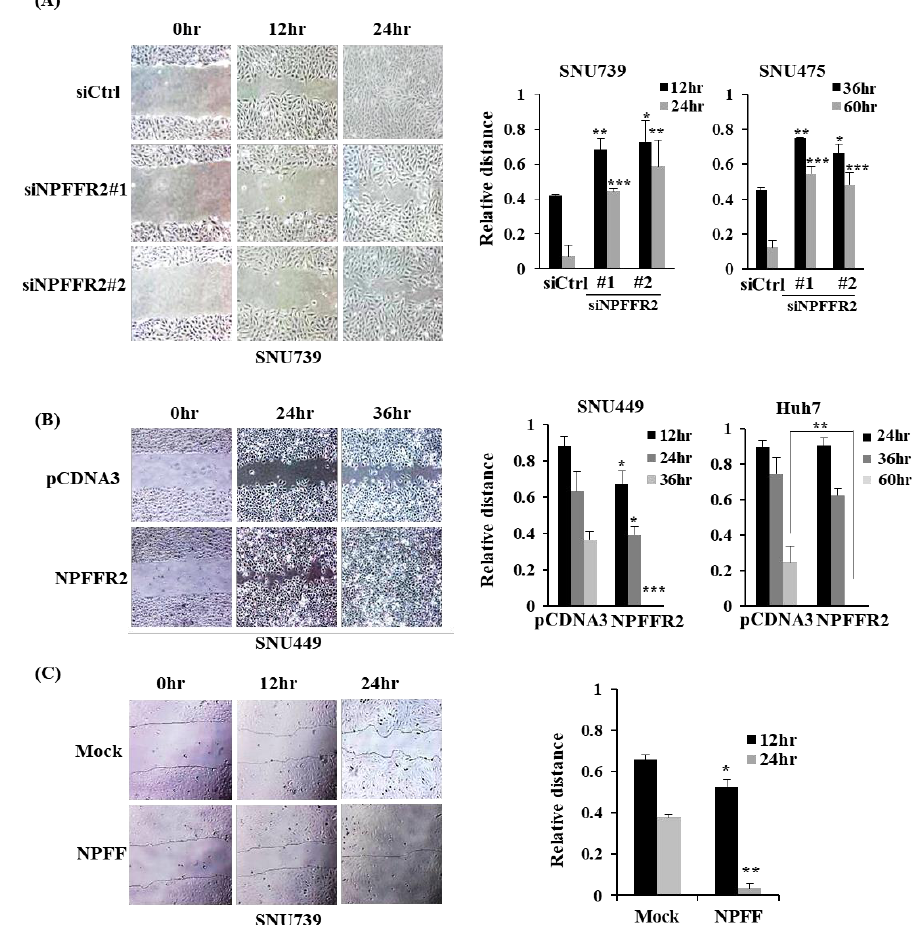
Figure 4. NPFFR2 increases cancer cell migration. ( A – C ) A wound healing assay was performed with indicated HCC cells under conditions where NPFFR2 was depleted by siRNA ( A ), overexpressed by transient transfection ( B ), or activated by ligand ( C ). To verify the migration effect by regulation of NPFFR2 expression, cells transfected with siRNAs ( A ) or plasmids ( B ) for 24 h were prepared for the assay. To verify the migration effect of NFPPR2 ligand ( C ), starved cells were stimulated with complete media containing 3 μM of NPFF. At least three independent experiments were performed, and data are presented as the average of triplicate in one representative experiment. * indicates p < 0.05, ** indicates p < 0.01, *** indicates p < 0.001.